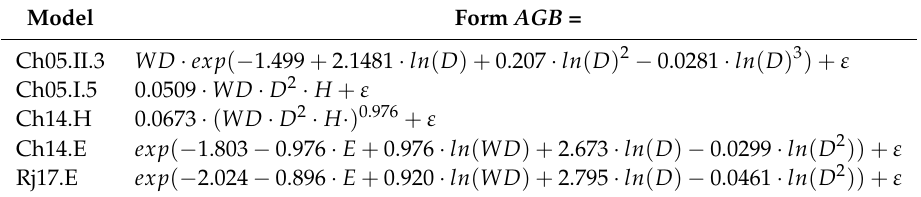
Table 1. Pantropical models from [11,12,46] included diameter at breast height ( D , in cm), specie-specific wood density values according to the GWDD ( WD , in gcm − 3 or kgm − 3 ), total height ( H , in m), the environmental stress ( E , calculated from the GPS average location of each tree 1 ) to estimate aboveground biomass ( AGB , in kg dry mass) and ε is the model